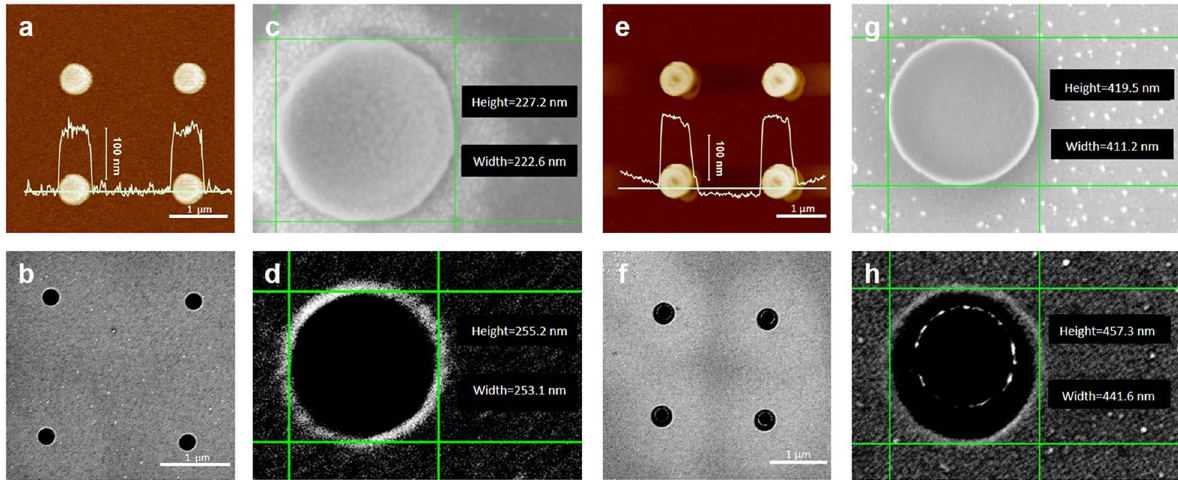
Figure 5. Characterization during the fabrication process of nanopore array. AFM topography of PMMA pillar and HSQ capping obtained by oxygen plasma etching ( a , e ) and the size measurement charts based on SEM ( c , g ). SEM photos of nanopore array after lift-off ( b , f ) and the size measurement charts based on SEM ( d , h ). The structures in ( a – d ) are 250 nm, and in ( e – h ) are 450 nm. The yellow curves are the height curves corresponding to the green lines in ( a , e ), and the scale bars in z-axis are 100 nm.